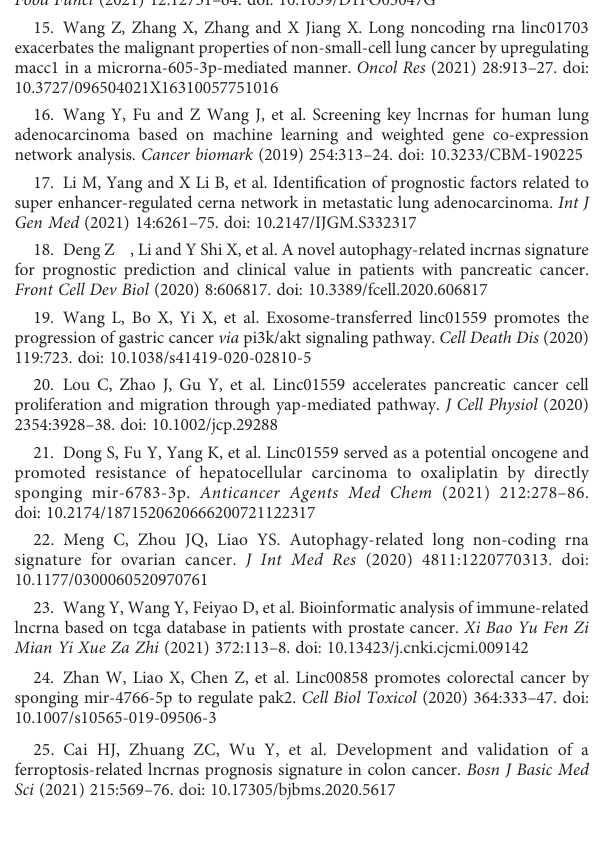
SUPPLEMENTARY TABLE 1 A total of 279 differentially expressed metabolism-related genes were obtained, of which 151 genes were down-regulated and 128 genes were up-regulated.